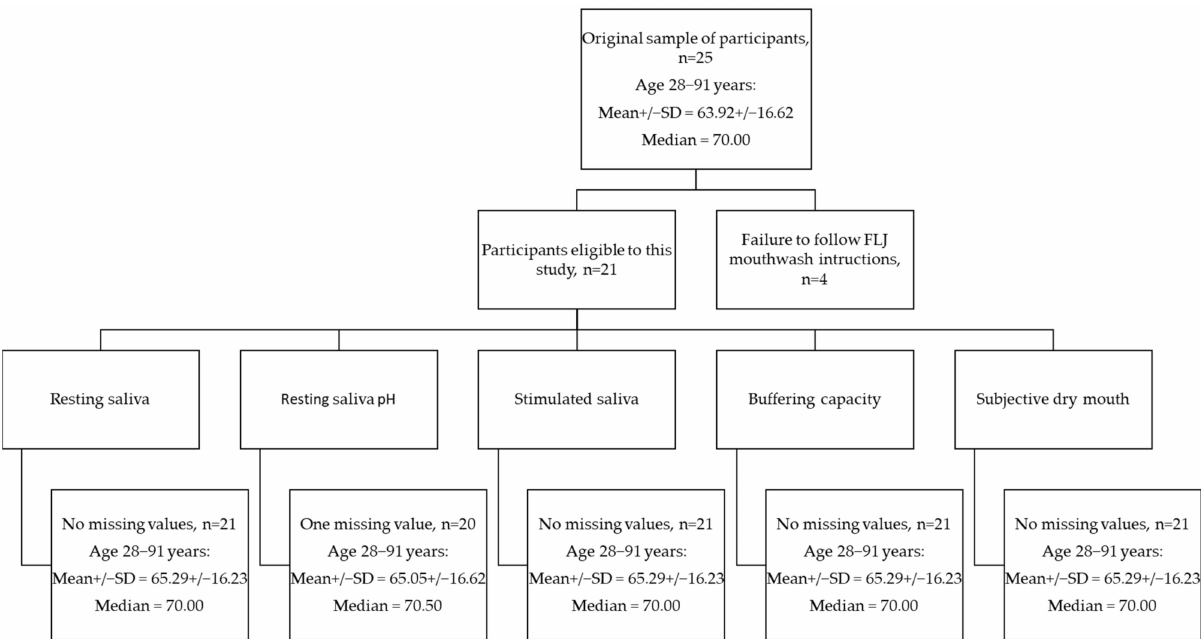
Figure 1. Flowchart of sample number and age of participants in the current study. Number of diseases belonging to endocrine and metabolic, mental and behavioral, circulatory system, and respiratory system were classified according to the International Statistical Classification of Diseases and Related Health Problems [17]. The number of medications reported with higher or moderate level of evidence to induce xerostomia included medications for endocrine and metabolic (diabetes), the circulatory system (high blood pressure), and mental and behavioral diseases [2]. The results of the salivary parameters are shown in Figure 2. The FLJ mouthwash had positive effect on all five salivary parameters, and according to the omnibus test, all parameters were statistically significant during the study period (three measuring